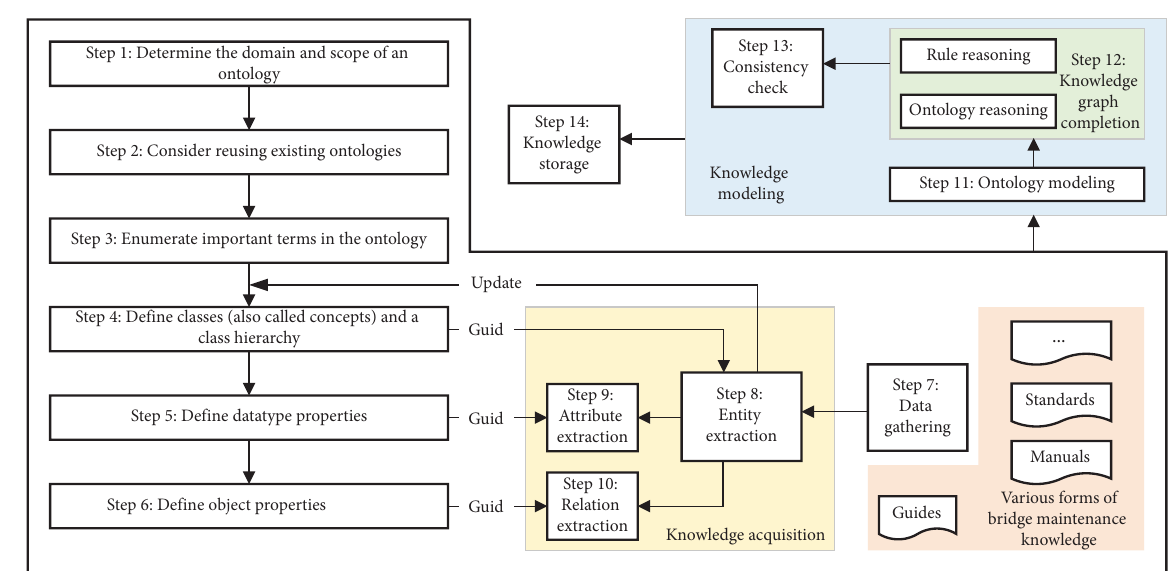
Figure 3: A workfow for building the